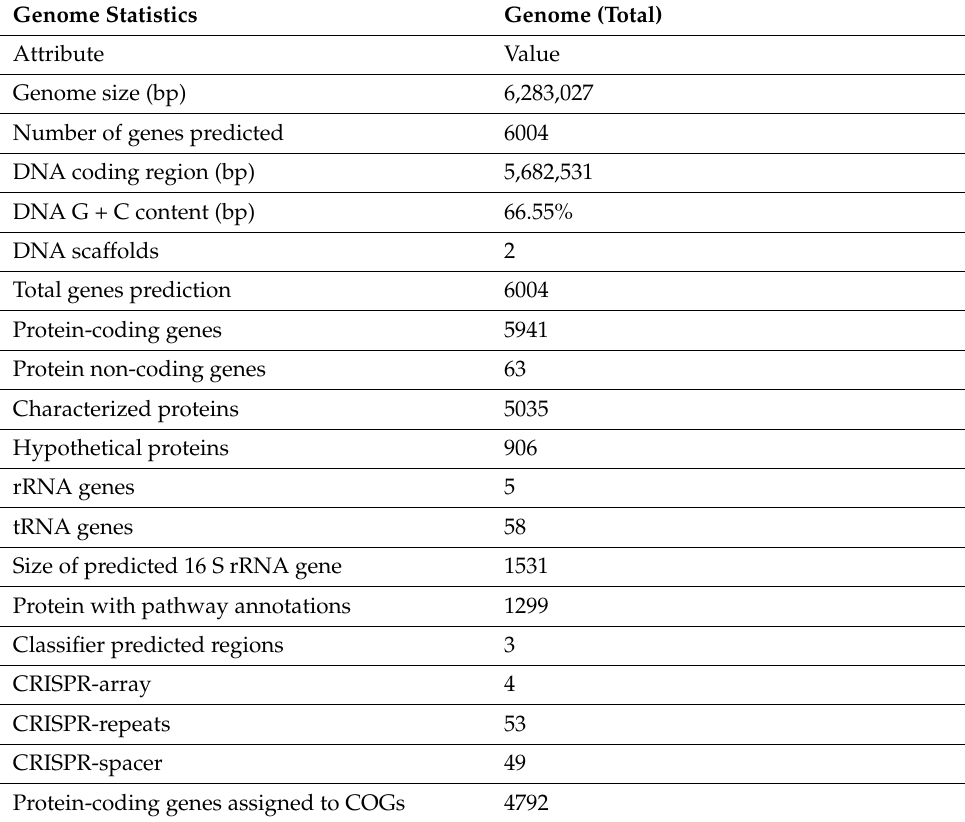
Table 6. General features of the P. aeruginosa strain FG106